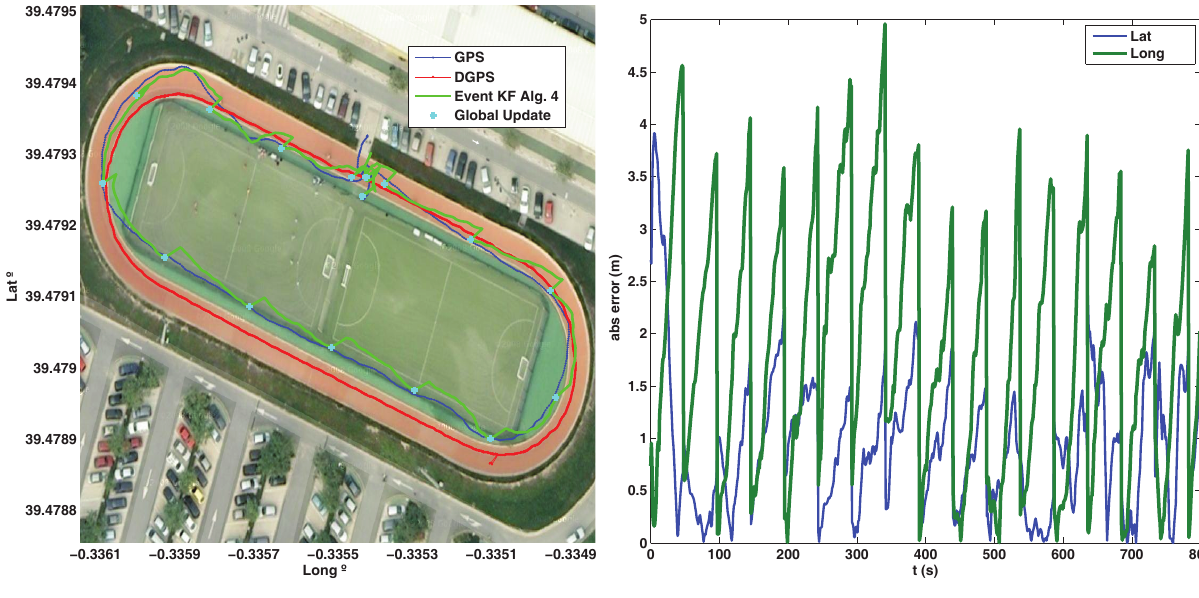
Figure 12. Ackermann Outdoor test, validation with